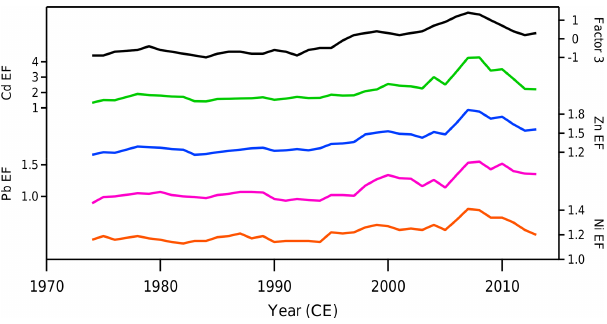
Figure 3. Comparison of 5-year running means of Factor 3 scores with Cd, Zn, Pb, and Ni EFs between 1971 and